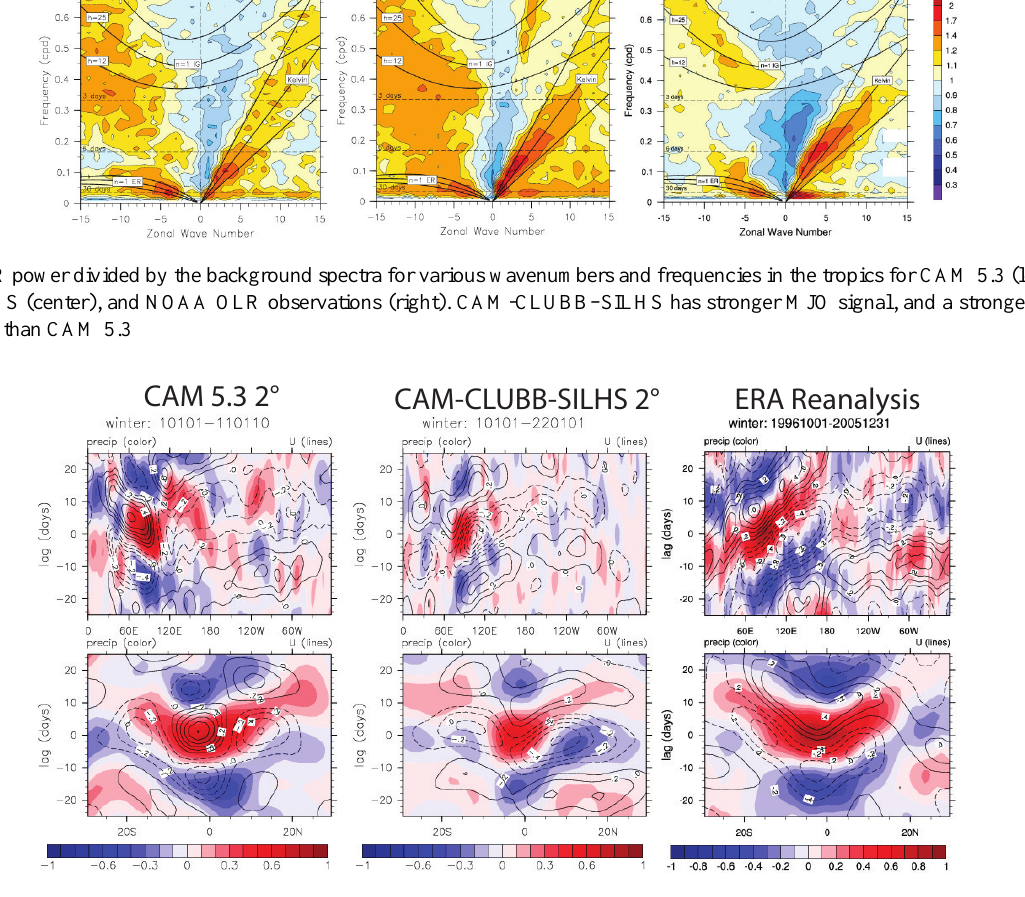
Figure 10. Lag-Longitude plots of winter MJO wave activity (top row), and Lag-Latitude plots of winter MJO wave activity (bottom row) for CAM 5.3 (left column), CAM-CLUBB–SILHS (center column), and ERA Reanalysis (right column). Precipitation is denoted by colors, zonal wind by lines. The signal in CAM-CLUBB–SILHS is weaker than observations, but the wave is moving eastward, rather than westward as in CAM